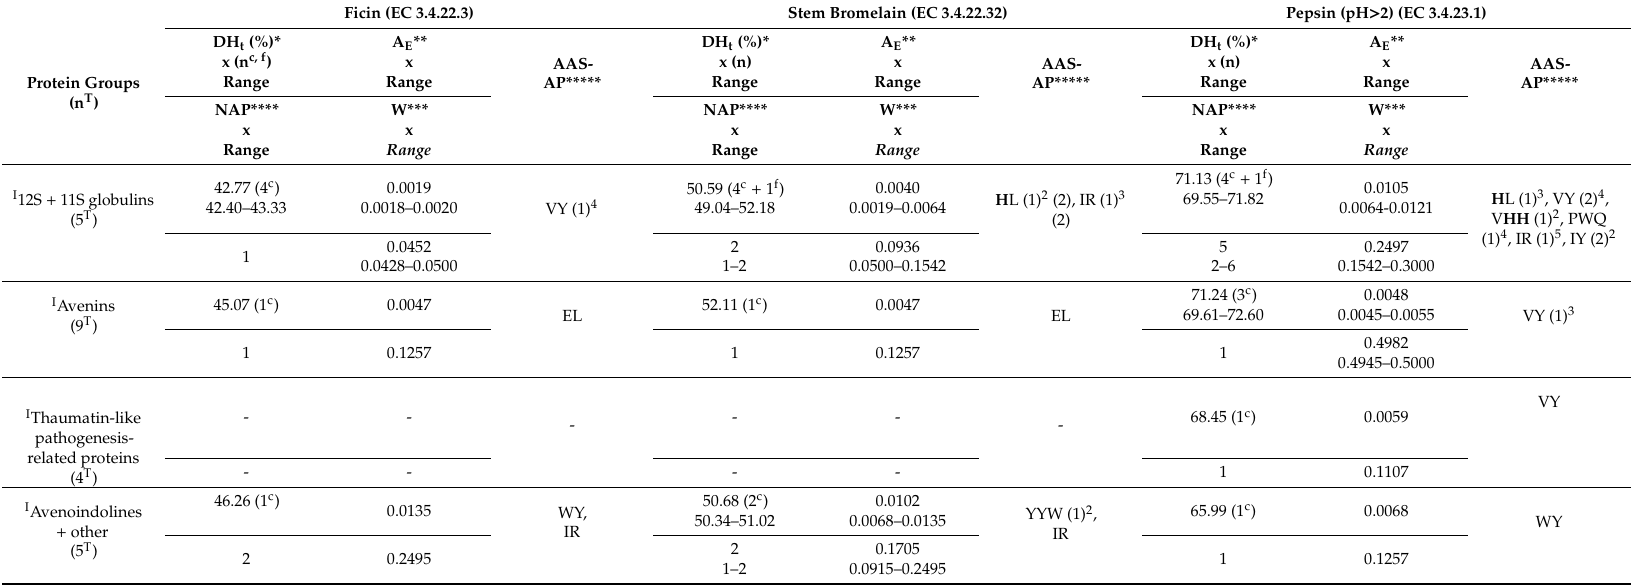
Table 9. The bioparameters characterising the in silico hydrolysis of oat proteins ( I Avena sativa) and the molecular characterisation of the obtained antioxidant peptides.